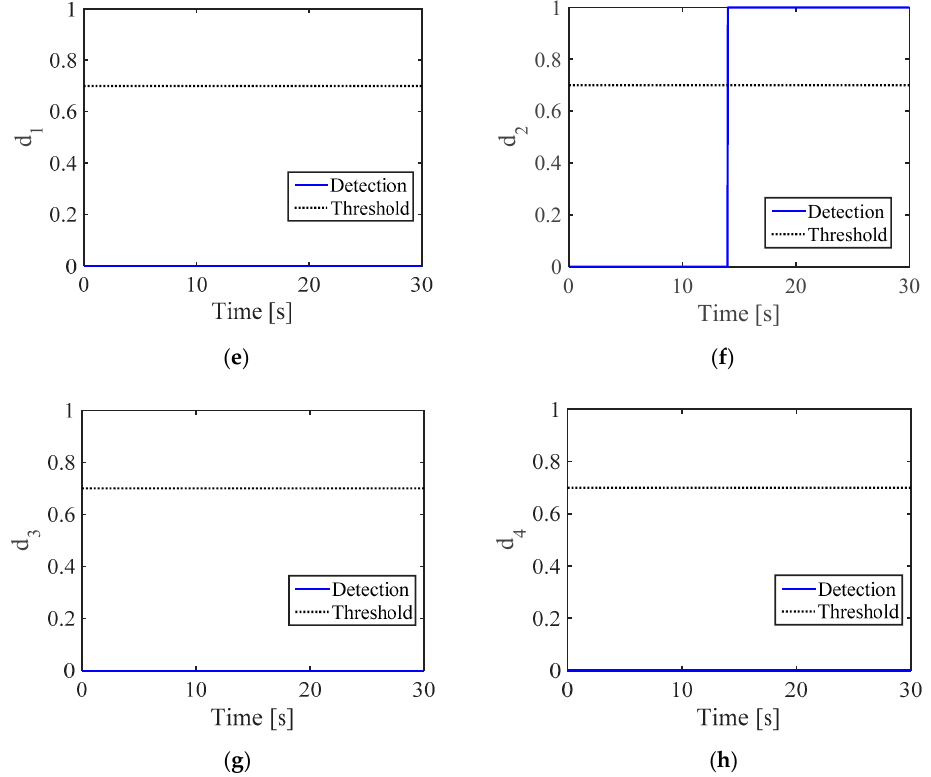
Figure 10. Forces and detection units for scenario 1: ( a ) motor 1 ′ s force, ( b) motor 2 ′ s force, ( c ) motor 3 ′ s force, ( d ) motor 4 ′ s force, ( e ) fault detection of motor 1, ( f ) fault detection of motor 2, ( g ) fault detection of motor 3, and ( h ) fault detection of motor 4.